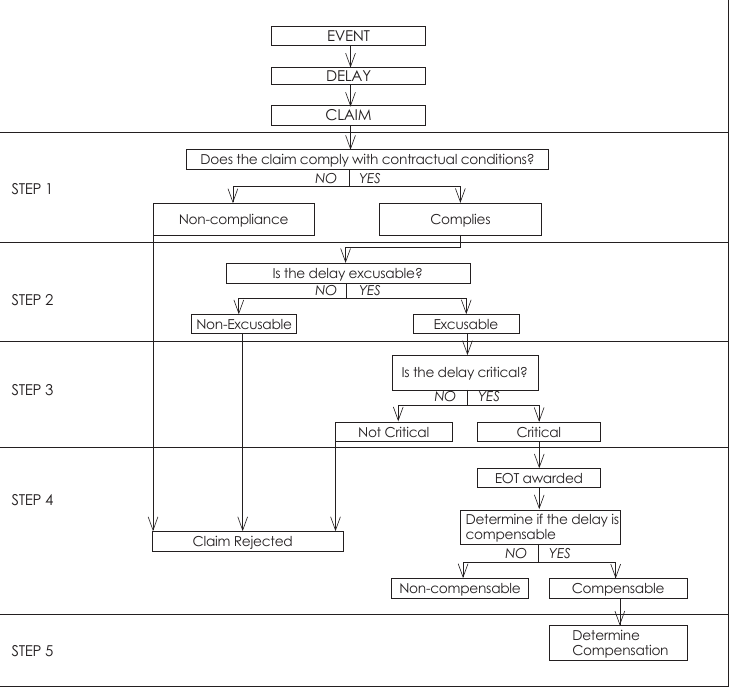
Figure 3: Universal decision-tree framework The principles defined as part of the universal decision-tree framework can be applied in the process of assessing EOT claims when utilising the JBCC